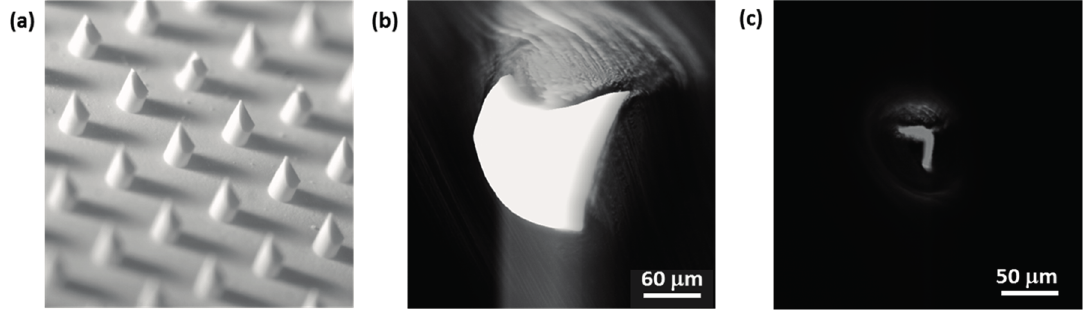
Figure 11. Detailed image analysis for a SN-fc-D300 npMNA on foam as a skin